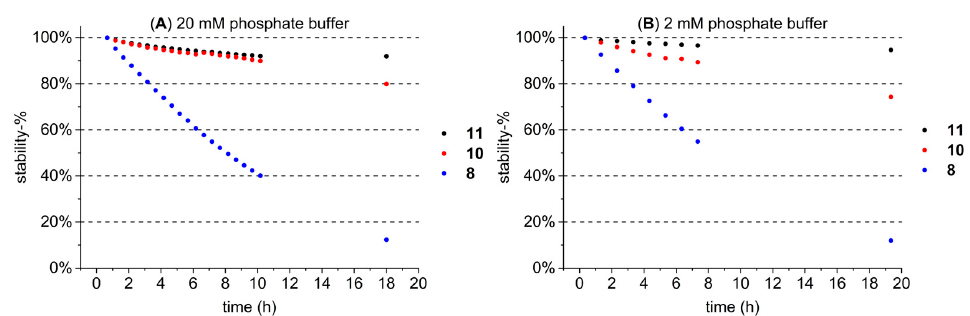
Figure 8. Stability of three HTs (pentagalloylglucose ( 11 ), tellimagrandin II ( 10 ), and vescalagin( 8 )) in 20 mM ( A ) and 2 mM ( B ) pH 7 sodiumphosphate buffer during approximately 20 h and presented as a stability ‐ %, i.e., the percentage from the initial injection. The last data points were analyzed the next morning when the instrument was free, explaining the difference in the last data point’s time.